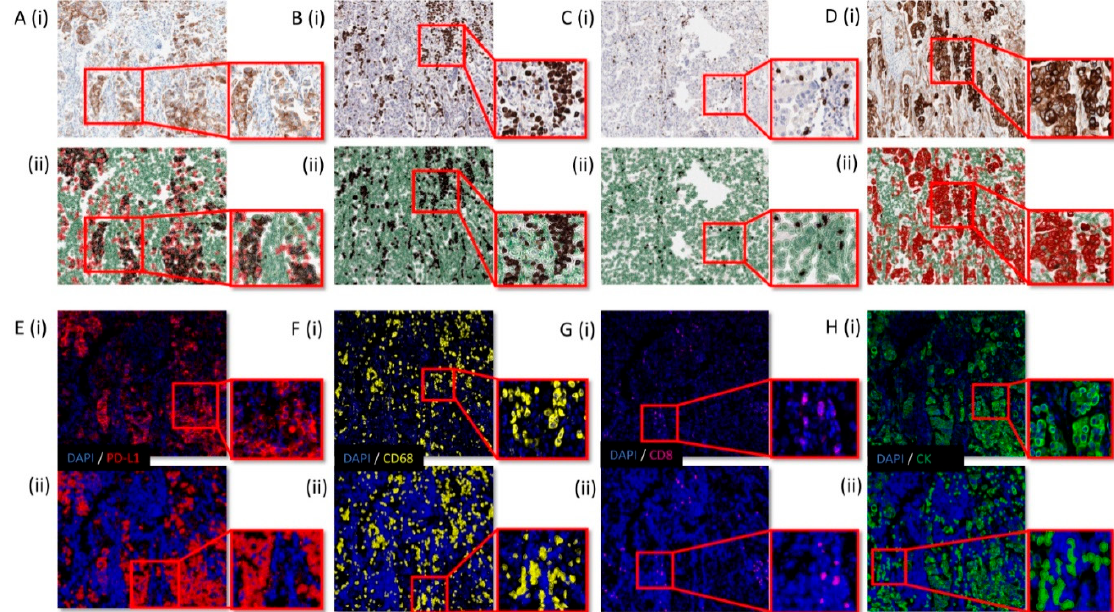
Figure 1. Optimised chromogenic immunohistochemistry (IHC) and single channel multiplex immunofluorescence (mIF) staining. ( A – D ) ( i ) represents optimised DAB IHC for PD-L1, CD68, CD8, and CK, respectively. ( A – D ) ( ii ) represents the QuPath image analysis mask applied to the optimised DAB IHC images. In ( A ) ( ii ), the tumour class is coloured red, while stroma is green. PD-L1 positive cells are black within the red tumour class. In ( B ) ( ii ), positive CD68 cells are black and negative CD68 cells are green. In ( C ) ( ii ), positive CD8 cells are black and negative CD8 cells are green. In ( D ) ( ii ), positive CK cells are red and negative CK cells are green. ( E – H ) ( i ) represent optimised single fluorescence Opal staining for PD-L1, CD68, CD8, and CK, respectively. ( E – H ) ( ii ) represents the QuPath image analysis mask applied to the optimised DAB IHC images. In ( E ) ( ii ), PD-L1 positive cells are red with all other cells blue. In ( F ) ( ii ), positive CD68 cells are yellow and negative CD68 cells are blue. In ( G ) ( ii ), positive CD8 cells are purple and negative CD8 cells are blue. In ( H ) ( ii ), positive CK cells are green and negative CK cells are blue. All images are 10× magnification with an ROI shown as an exploded view at 20× magnification.